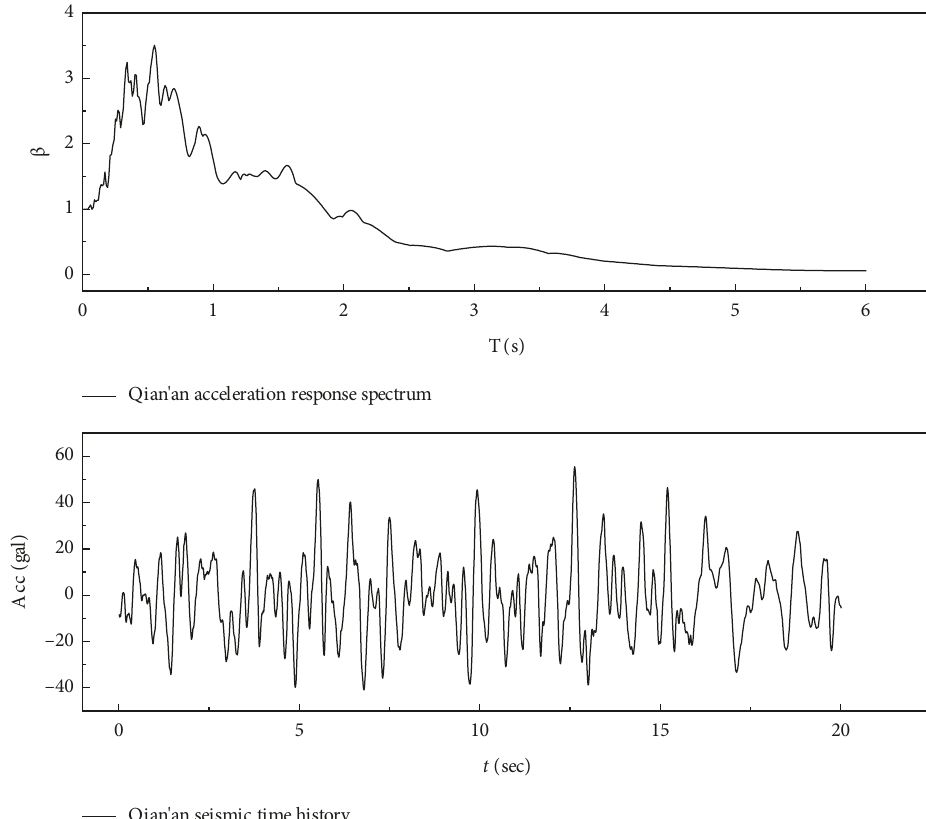
Figure 4: Qian’a earthquake acceleration response spectrum and time history